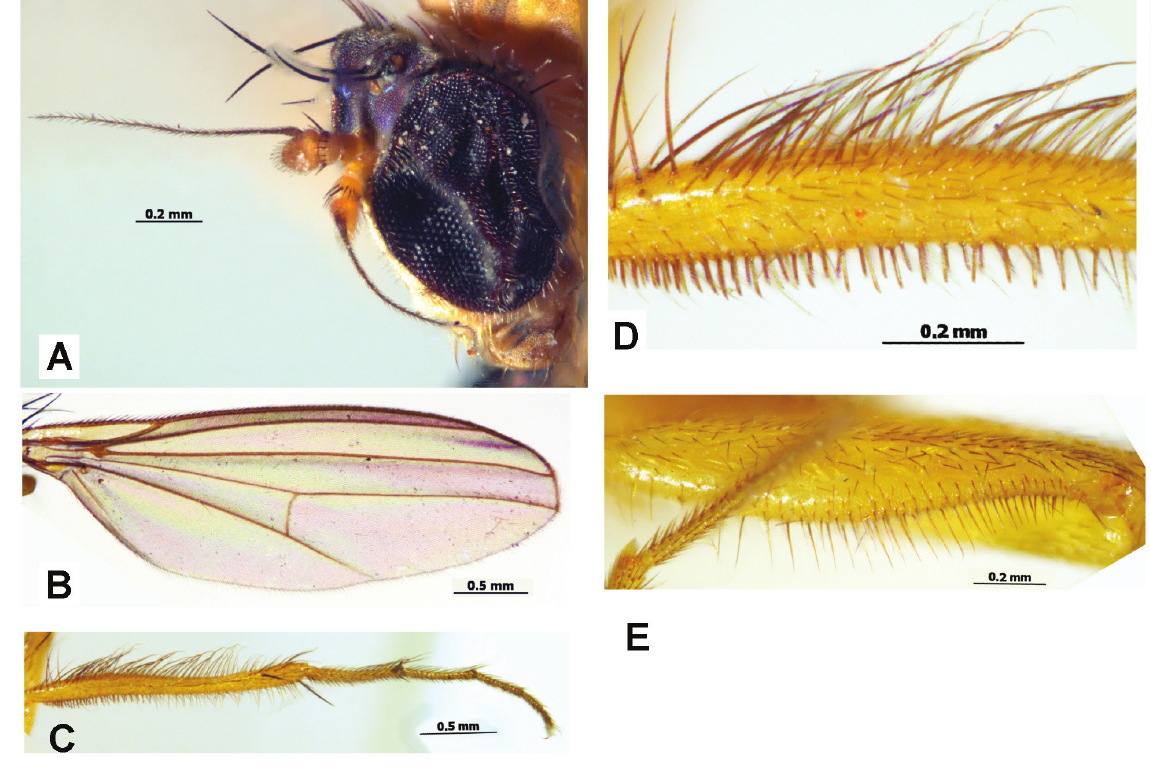
Fig. 3. Campsicnemus flavissimus sp. nov., ♂ holotype and ♀ paratype. A . ♀ head. B . ♂ wing. C . ♂ mid tibia and tarsus. D . ♂ mid tibia, basal part. E . ♂ mid